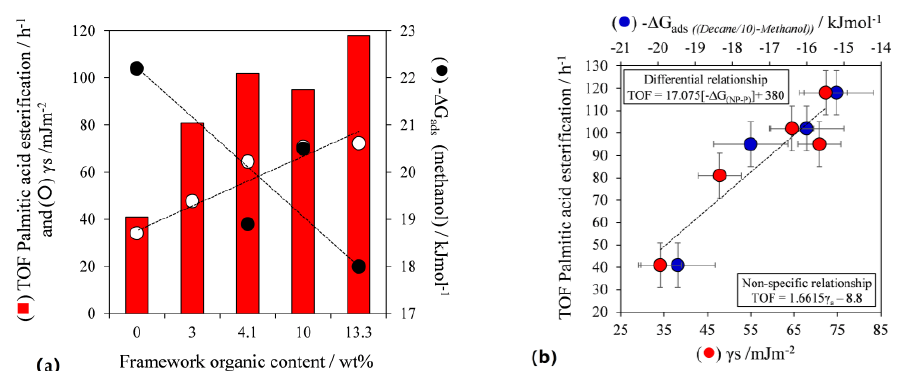
Figure 5. ( a ) Impact of framework organic content on PMO surface properties as determined from IGC and TOF for palmitic acid esterification with methanol. ( b ) Correlation of dispersive energy and [−∆𝐺 𝑁𝑃−𝑃𝐶 ] for decane and methanol, with TOF for palmitic acid esterification with methanol. Adapted from Reference [59]; copyright (2014) with permission from Elsevier.